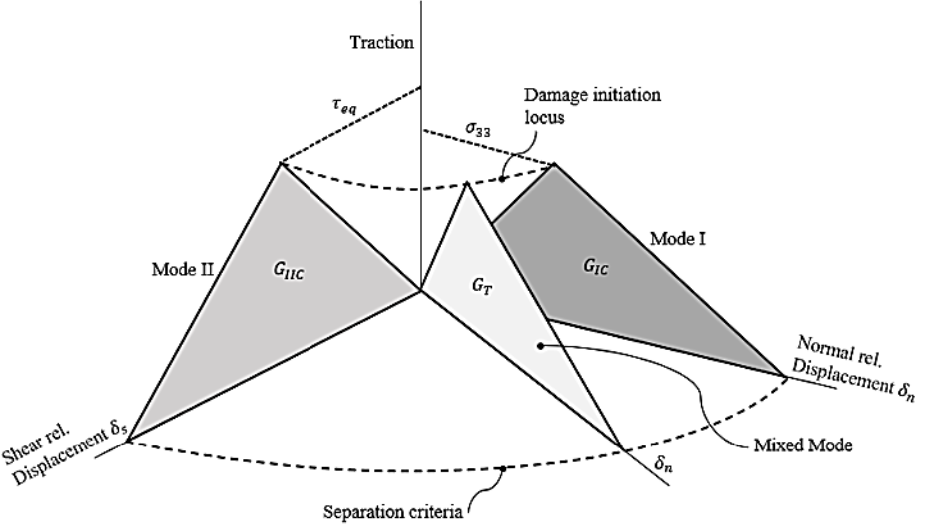
Figure 1. Bilinear traction – separation softening law for the cohesive interface that faces quasi-static mixed-mode loading.